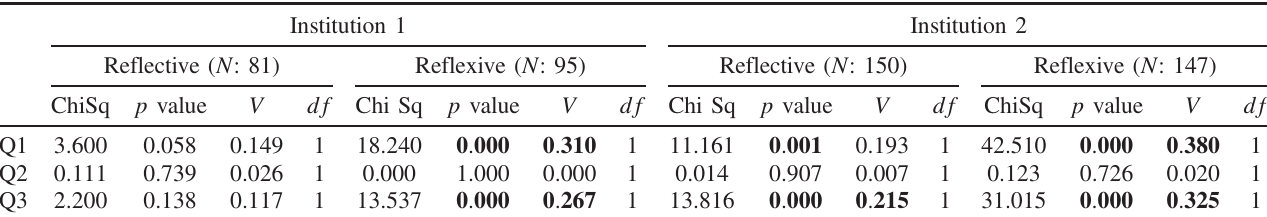
TABLE II. Results of 2 × 2 Chi-square test based on comparisons of correct and incorrect vs pre and post. The tests were performed for each condition at each institution. Bold-face p-value indicates statistical significance, and bold-face effect-size (V) indicates medium to large effect